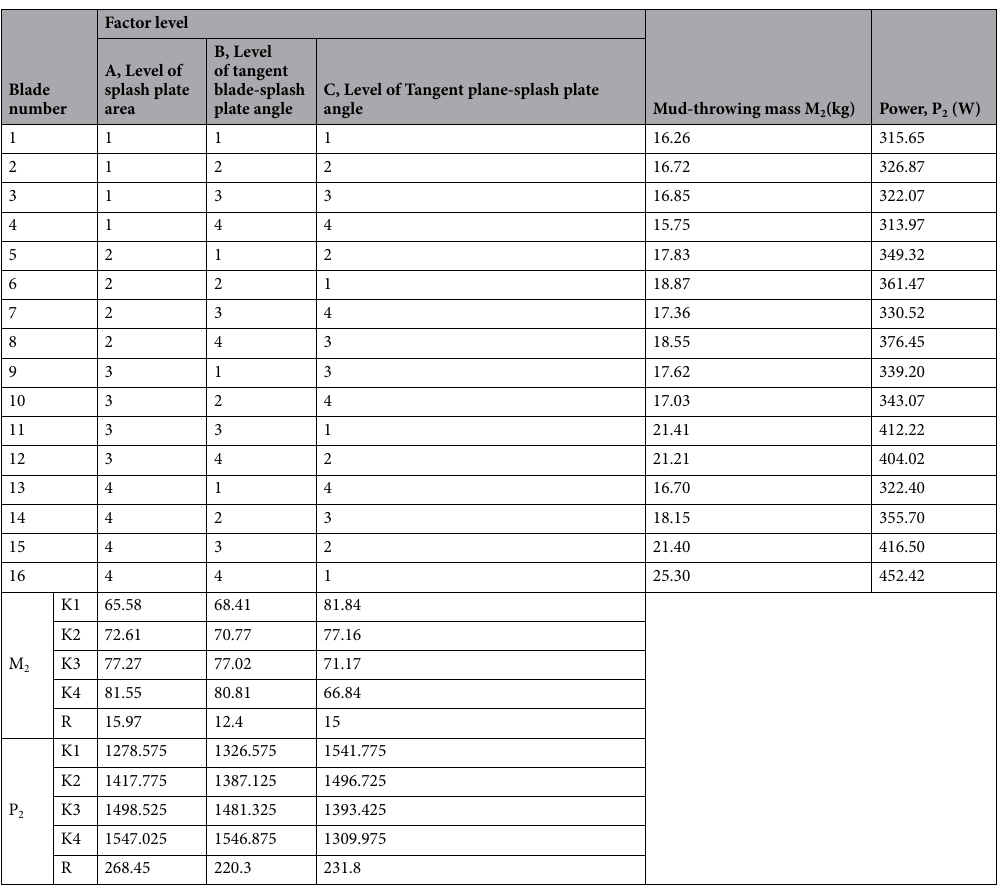
Table 2. Experimental method and results. M 2 is mud-throwing mass and P 2 is power obtained in the experiment.